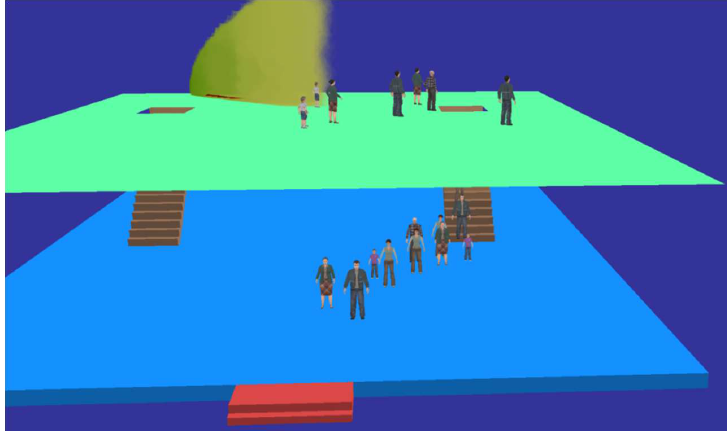
Figure 8. The 3D scene of individual behavior simulation in an emergency. The upper middle area shows the region of emergency diffusion.